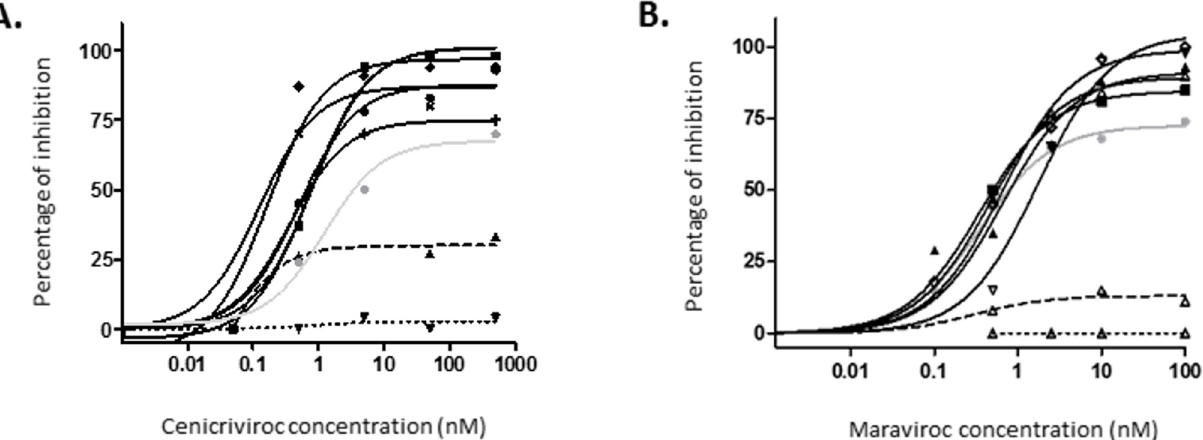
Fig 1. Dose response curves for cenicriviroc-dependent inhibition (A) and maraviroc-dependent inhibition (B). R5, dual and X4-tropic HIV-2 strains are depicted in continuous, dashed and dotted black lines, respectively. HIV-1 R5-tropic strain is depicted using the continuous gray line.